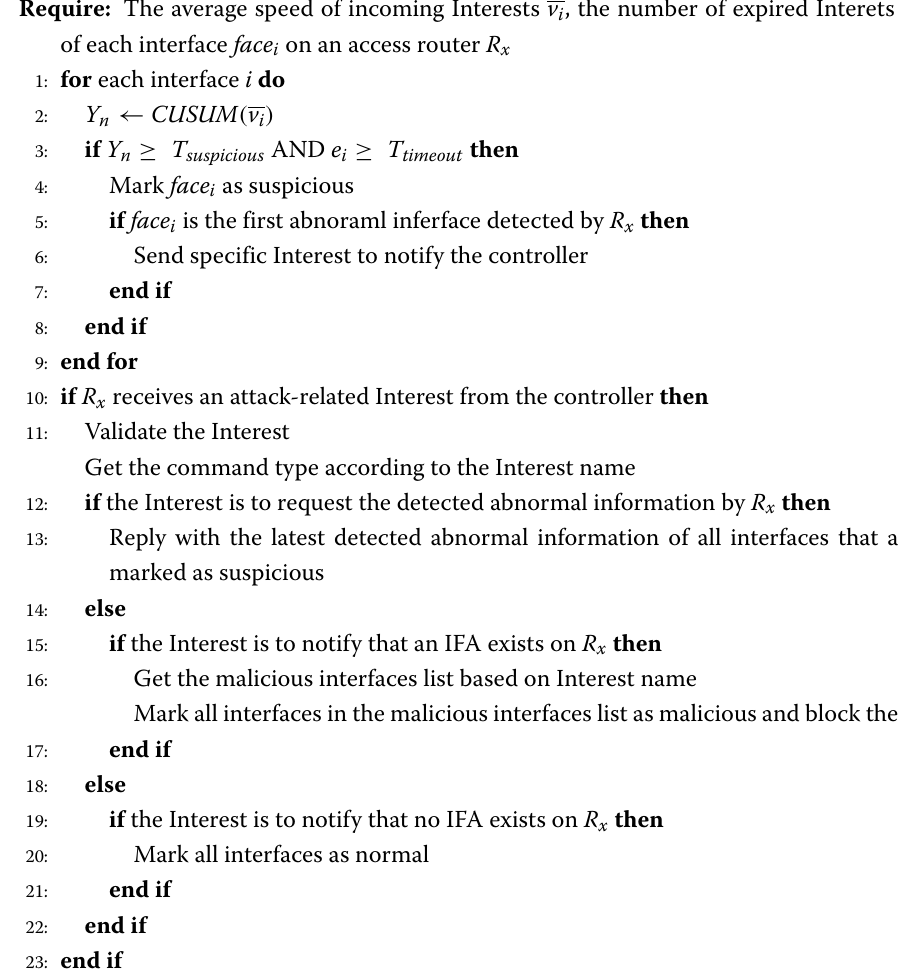
Algorithm 1 Process of attack detection and mitigation at an access